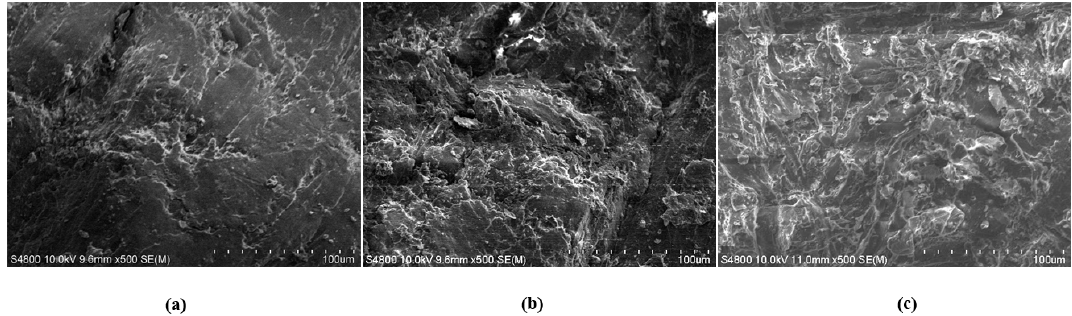
Figure 11. Circular surface morphology of φ 8mm biomass pellet: ( a ) d = 8.26 mm, D = 1.789, ( b ) d = 8.58 mm, D = 1.588, ( c ) d = 8.76 mm, D =